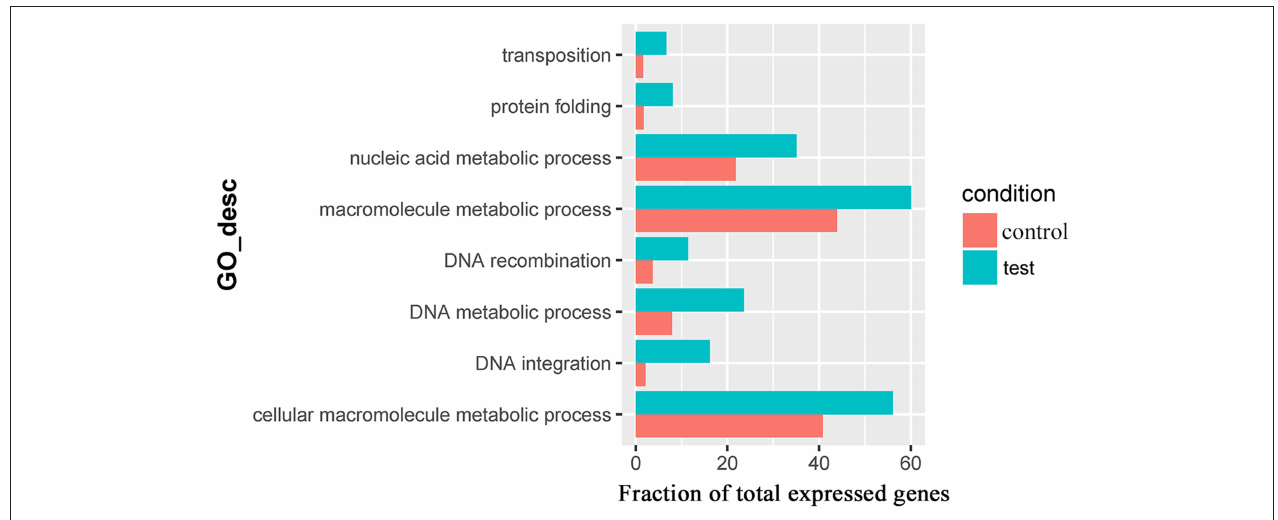
FIGURE 4 | The overrepresented GO terms of the significantly upregulated genes in the Control_10h/Heat_10h comparison of coral Galaxea fascicularis .